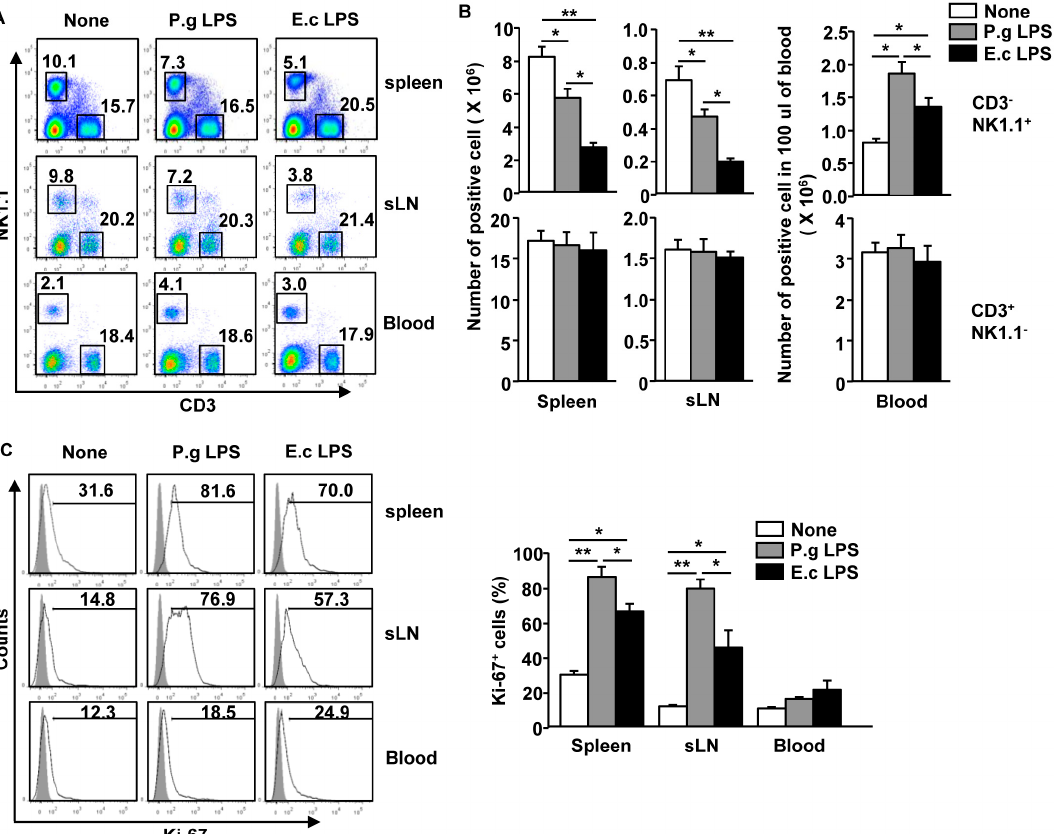
Figure 1. P. gingivalis LPS enhanced the proliferation of spleen and submandibular lymph node (sLN) natural killer (NK) cells in vivo. C57BL/6 mice were injected intravenously ( i.v. ) with 1 mg/kg of P. gingivalis (P.g) LPS or E. coli (E.c) LPS for 18 h. ( A ) The percentage of CD3 − NK1.1 + and CD3 + NK1.1 − cells in the spleen, sLNs, and blood were analyzed by flow cytometry; ( B ) Absolute cell number of CD3 − NK1.1 + and CD3 + NK1.1 − cells within live cells in the spleen, sLNs, and blood are shown; ( C ) Intranuclear expression levels of Ki-67 in the CD3 − NK1.1 + cells in the spleen, sLNs, and blood are shown ( left panel ). The mean percentage of Ki-67 positive cells in the CD3 − NK1.1 + in the spleen, sLN, and blood were illustrated ( right panel ). All data are representative or the average of analyses of six samples from three independent experiments. * p < 0.05, ** p < 0.01.